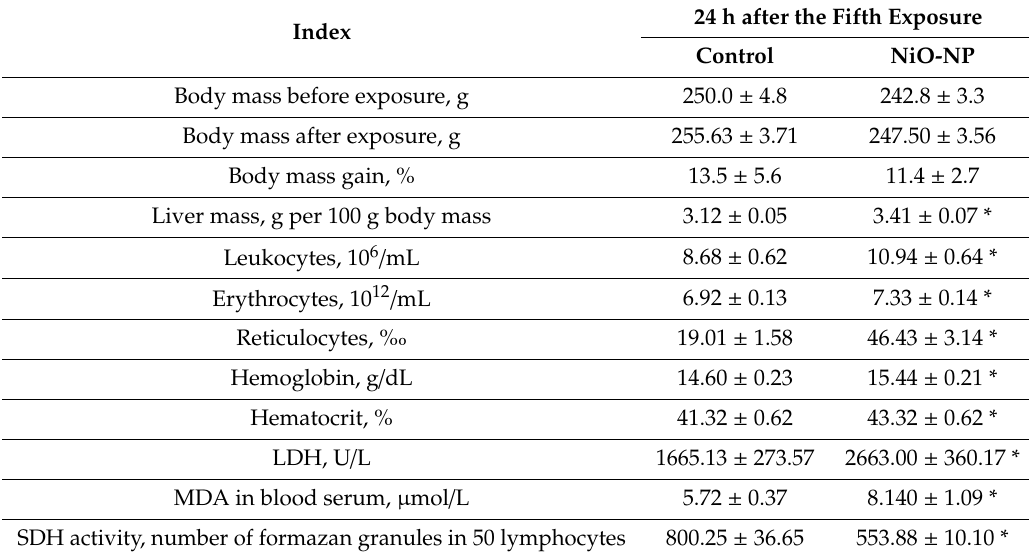
Table 1. Some indices of rat organism status after a short-term inhalation exposure to NiO nanoparticles